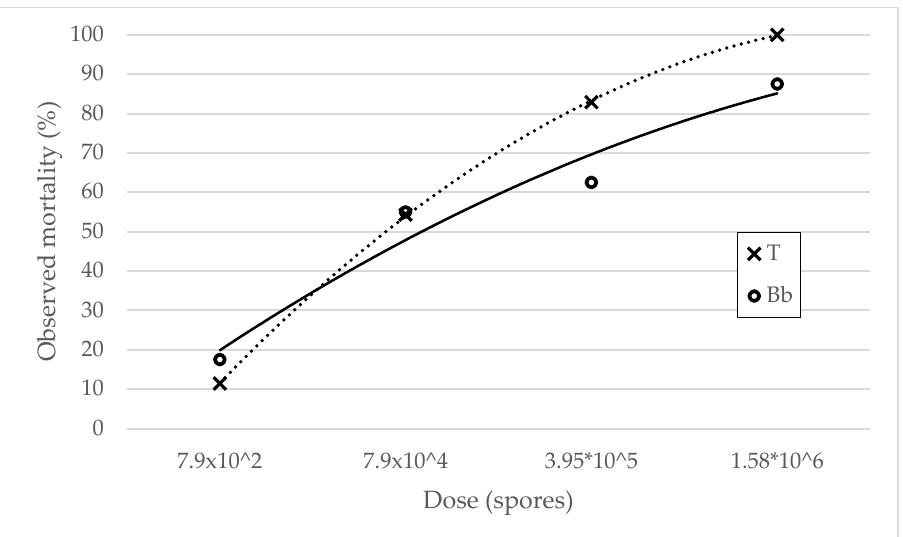
Figure 1. Total (T) and B. bassiana attributed (Bb) relative mortality as a result of dose and associated dose response curves plotted as polynomic regression of the second order. Abbott’s formula was used for calculation of relative mortality rates. Equations and coefficients of determination for T and Bb dose response curves were y = −6.45 x 2 + 61.69 x − 43.7; R 2 = 0.9999 and y = −3.125 x 2 + 37.375 x − 14.375; R 2 = 0.9552, respectively.